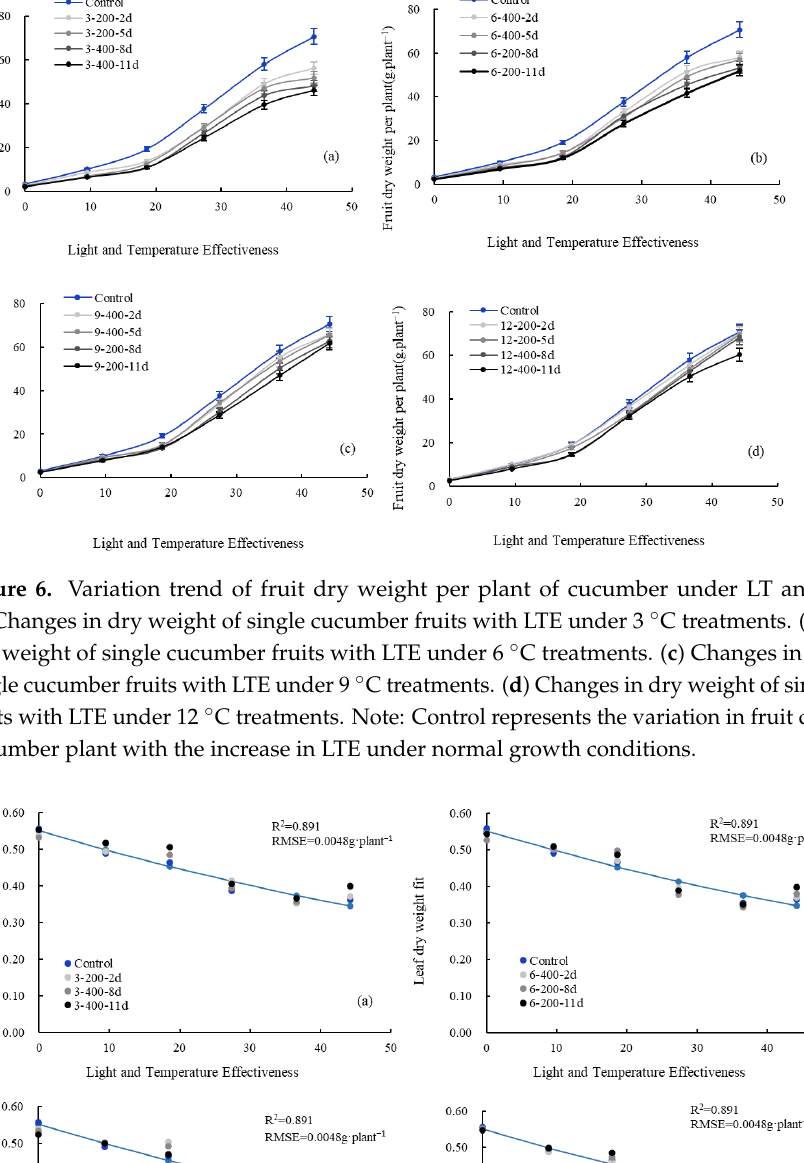
Figure 7. The relationship between the leaf dry weight distribution ratio of cucumbers and LTE under